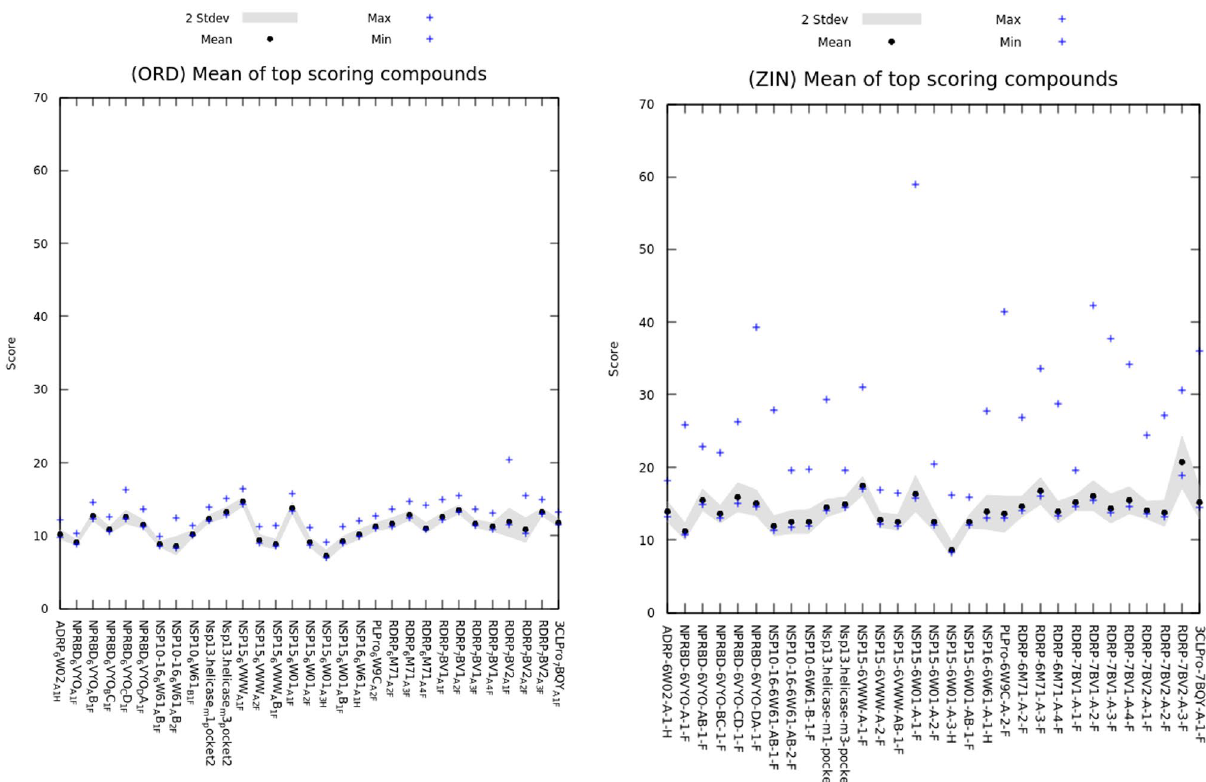
Figure 5. Comparison of the 31 receptor models with the 2000 best scoring compounds from ORD and